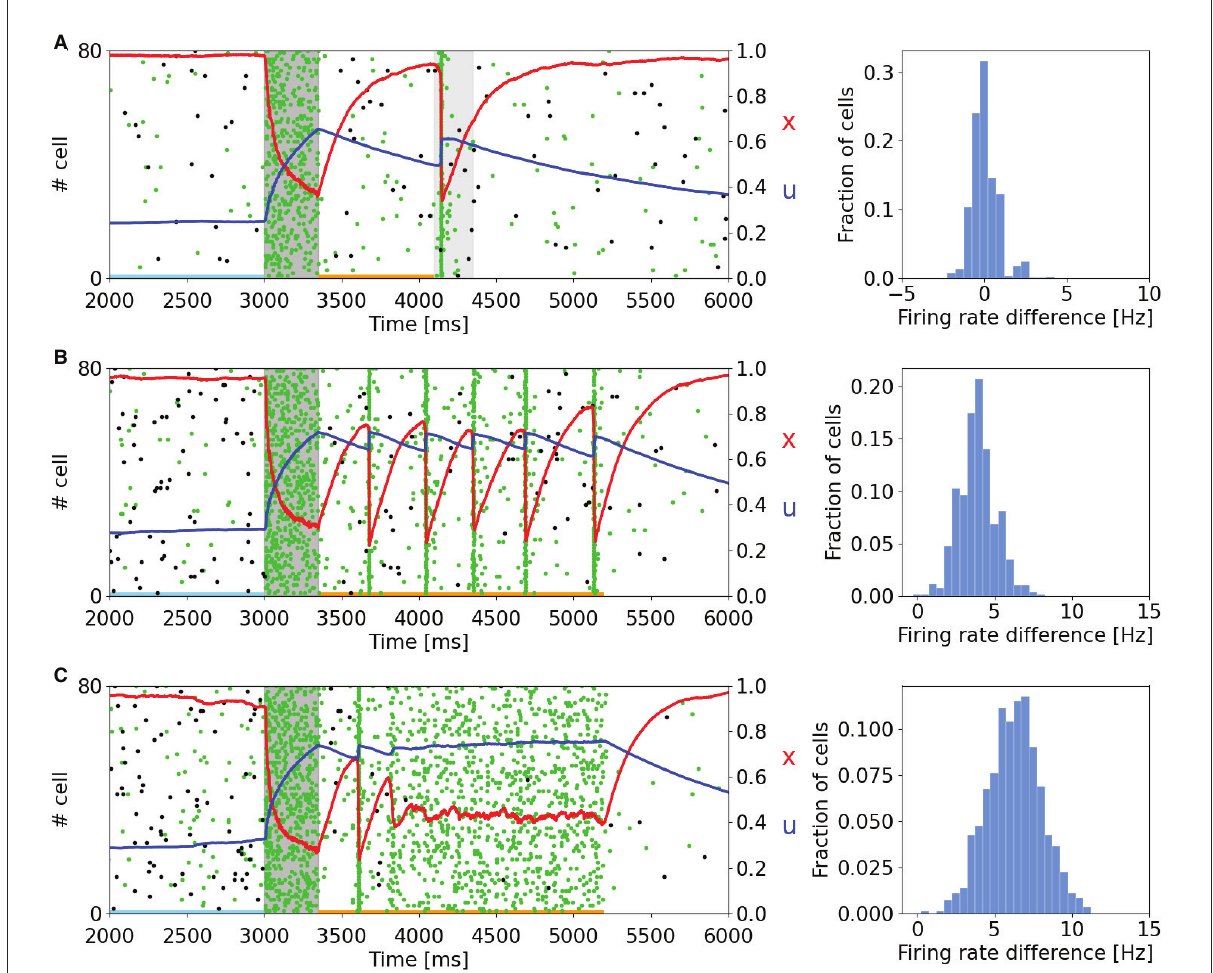
FIGURE2 Raster plots of a subset of neurons of a targeted selective population (green) and a non-targeted one (black) for different values of background input. Averaged STP variables ( x in red and u in blue) of the synaptic connections belonging to the target population are also shown. (Left) (A) The network, after the end of the injection of the item loading signal (gray shading) does not show a significant difference in spiking activity until the injection of a nonspecific input targeting the whole excitatory population (lighter gray shading). (B) Network behavior with increased excitatory background input. In this case, the network autonomously reactivates the memory by showing periodic synchronized events. The network returns to its spontaneous state by diminishing the background input. (C) Network behavior with further increased background input. Here, the network shows an asynchronous enhanced spiking activity of the loaded memory. As in (B) , the network returns to its spontaneous state when background input diminishes. (Right) Histograms represent the difference in firing rate between the delay period and the spontaneous state for the selective population targeted by the item loading signal. The rate at the spontaneous state is calculated before the injection of the item loading signal (sky blue line at the bottom of the panels). In (A) , the delay period is intended as the time between the end of the item loading stimulus and the beginning of the nonspecific external input. In (B,C) , the delay period is defined as the time between the end of the item loading signal and the decrease in the external background input (here shown at 5.2s for both the panels). The delay period is indicated with an orange line at the bottom of the left